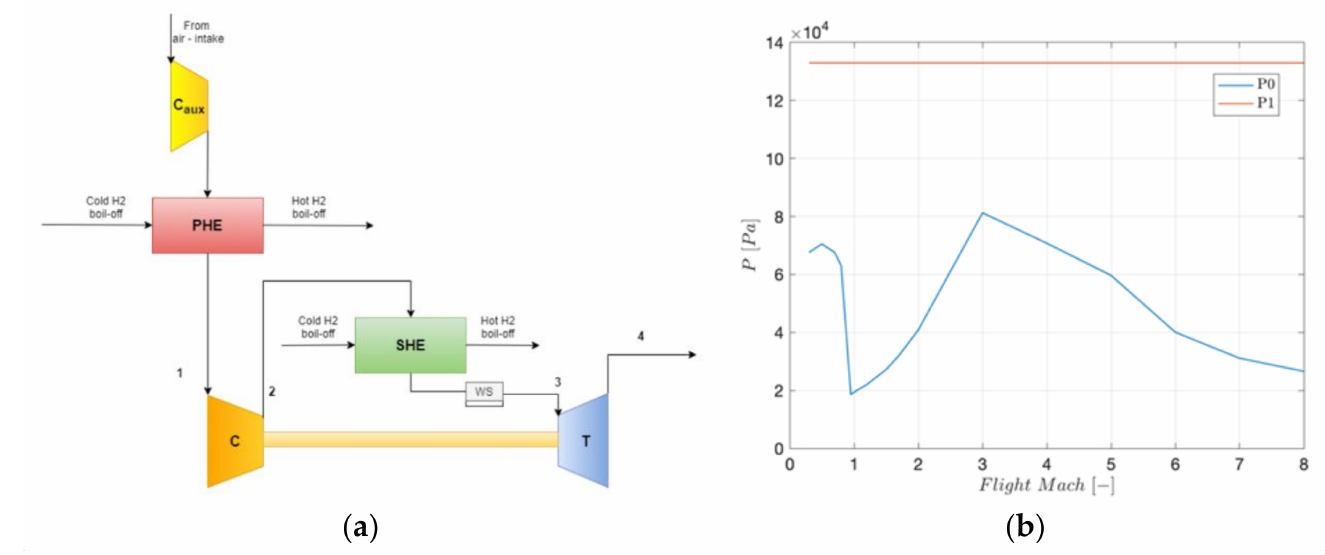
Figure 6. ( a ) Bootstrap sub-freezing air cycle machine CAU with an auxiliary compressor ( C aux ), a primary heat exchanger (PHE), a secondary heat exchanger (SHE), a water separator (WS), a compressor (C), and a turbine (T); ( b ) variation of the pressure of the ram-air extracted by the engine inlet duct (p 0 ) and of the air entering the CAU’s compressor (p 1 ) with Mach number.